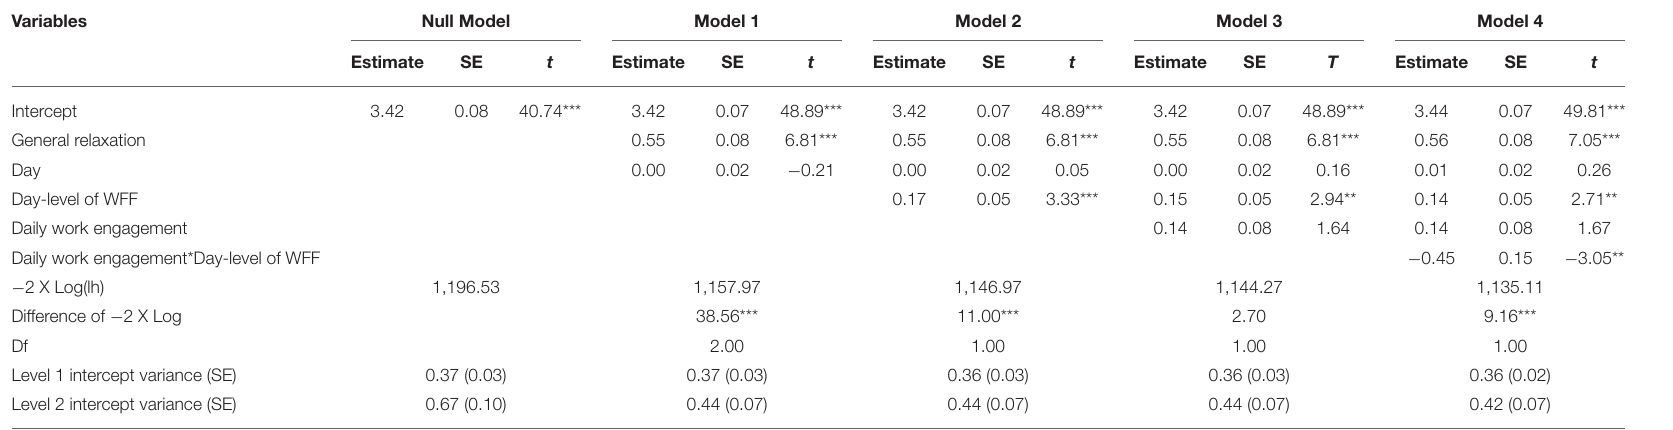
TABLE 3 | Multilevel estimates for models predicting day-level of relaxation ( N = 520 observations, N = 104